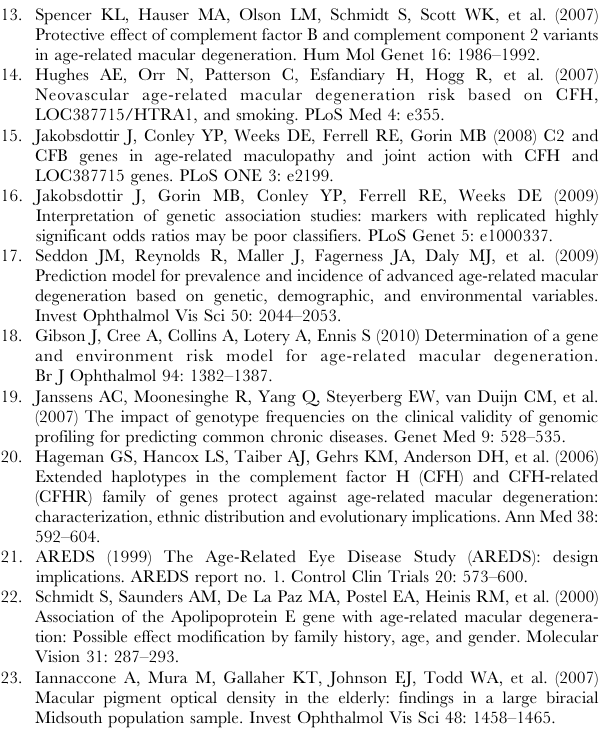
Figure S3 ROC analysis in the ARMA dataset. Area under the ROC = 0.67 (95% confidence interval 0.59 to 0.74.)